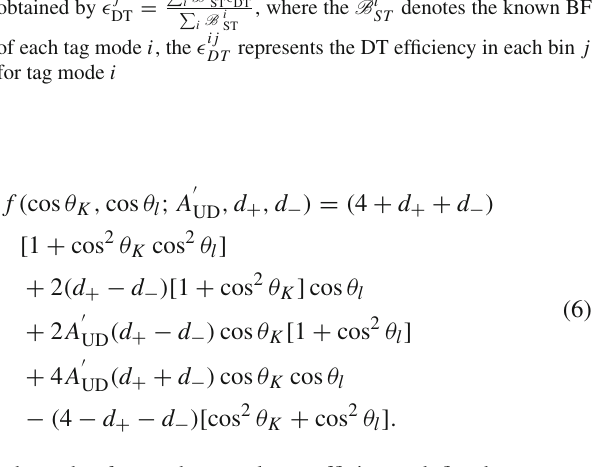
denotes the known BF ST